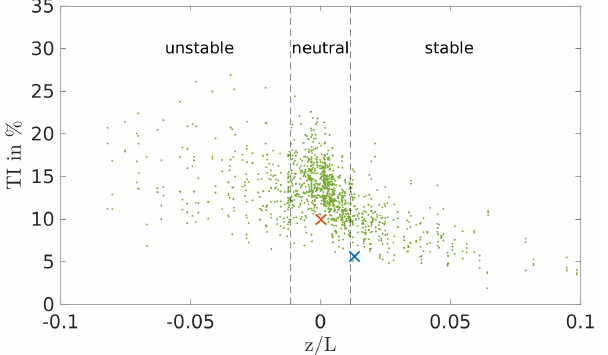
Figure 9. Turbulence intensity TI 92m of the measurement data (green) in comparison to the resulting TI 92m of the precursor runs sorted in neutral and stable (red – neutral; blue – stable).